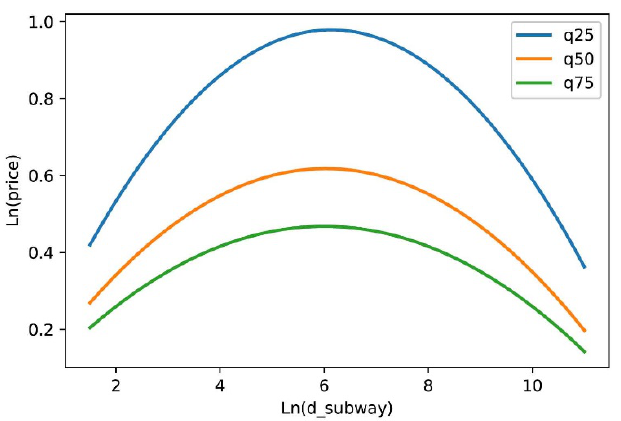
Figure 4. The functional relationship between housing price and distance from houses to subway stations (Equation (9)).